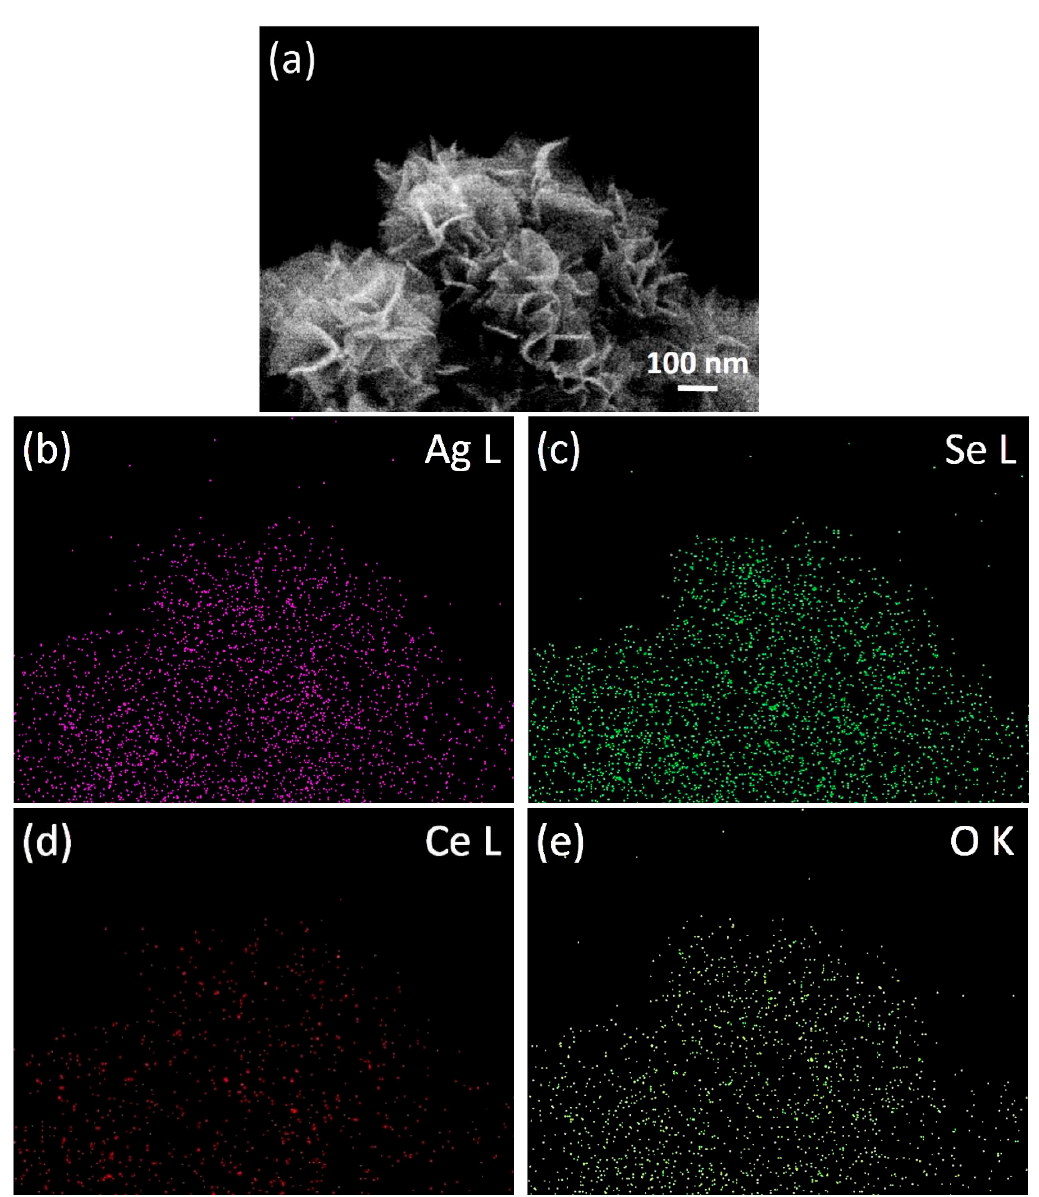
Figure 5. ( a ) SEM image and ( b − e ) elemental maps of 10% CeO 2 QDs/Ag 2 Se.